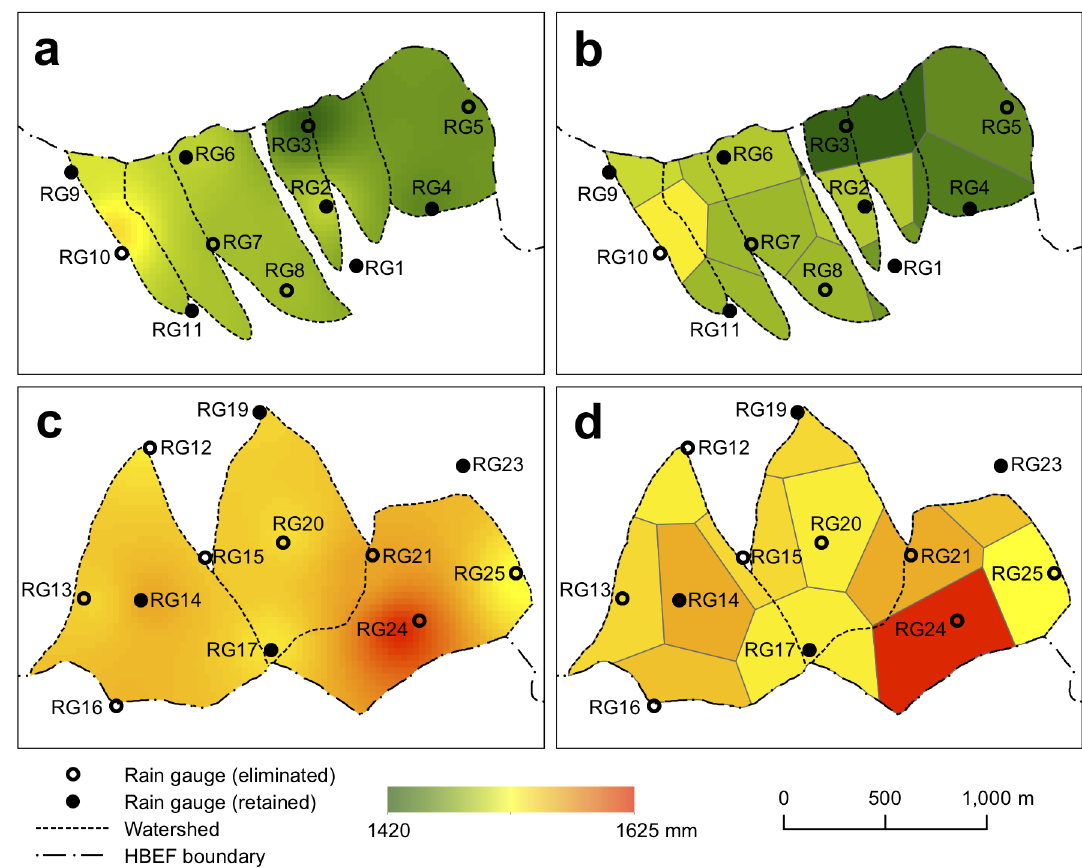
Fig 6. Spatial interpolation of precipitation for south-facing (a,b) and north-facing (c,d) catchments using the inverse distance weighting (a,c) and Thiessen polygon (b,d) methods. Open circles indicate gauges that were eliminated and closed circles indicate gauges that were